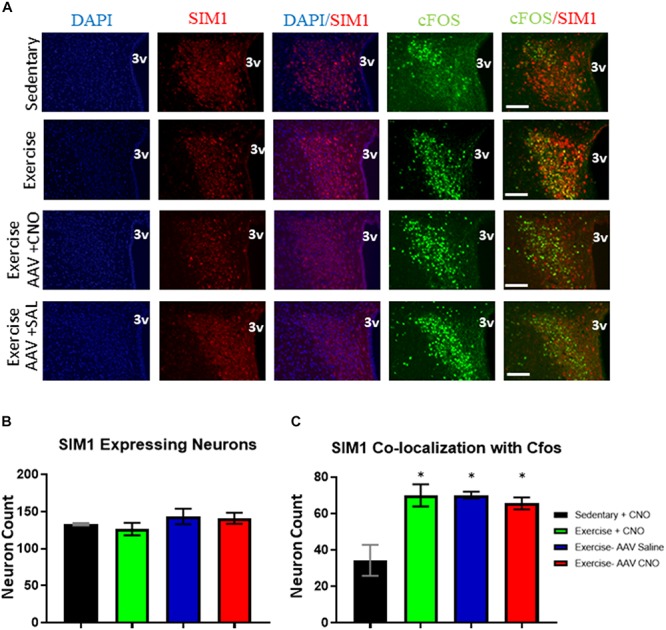
Acute exercise induces PVNSIM1 expressing neuronal activation independent of ARCAgRP/NPY neurons. (A) Immunofluorescence of SIM1-positive and cfos-expressing cells in the PVN from the sedentary, exercise, AAV CNO, and AAV Saline groups immediately after a bout of acute exercise. 3V = third ventricle; scale bars represent 50 μM. (B) Quantification of SIM1-positive cells in the PVN among the four groups. (C) Quantification of cfos colocalization with SIM1-positive cells in the PVN from the sedentary, exercise, AAV CNO, and AAV Saline groups immediately after a bout of acute exercise. 3V: third ventricle, scale bars represent 50 μm. Bar graphs show Mean + SEM. (N = 6 from 3 male mice per group), * indicates p < 0.05 vs. sedentary group.